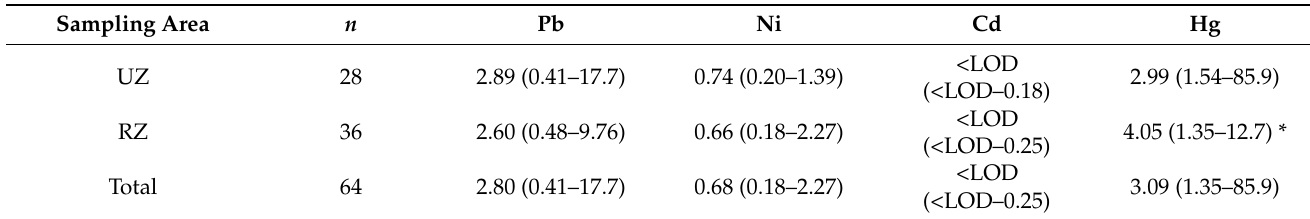
Table 2. THM levels (mg/kg) in feathers of Eurasian magpies sampled in urban zone (UZ) and rural zone (RZ). All data are ex pressed as median and range. LOD = limit of detection. Sampling